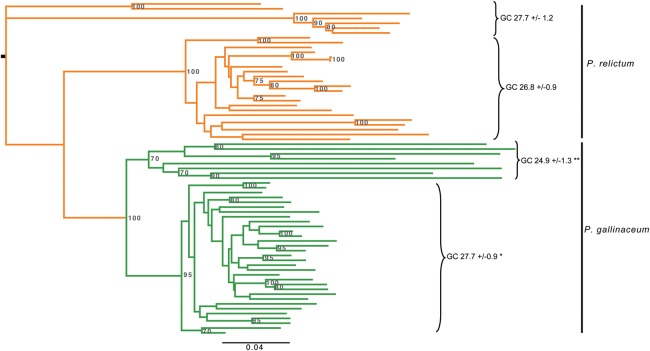
Phylogenetic analysis of 69 transposable elements from P. gallinaceum and P. relictum. For each element, GC-content is shown and clearly distinguishes two clades in P. gallinaceum. Unrooted maximum-likelihood tree based on nucleotides using the GTR+G evolutionary model. Bootstrap values < 70 are not shown. Percentage GC values indicate mean ± variance. P-values were determined based on a simple randomization approach; see Supplemental Methods. (*) P = <0.01, (**) P = <0.0001.